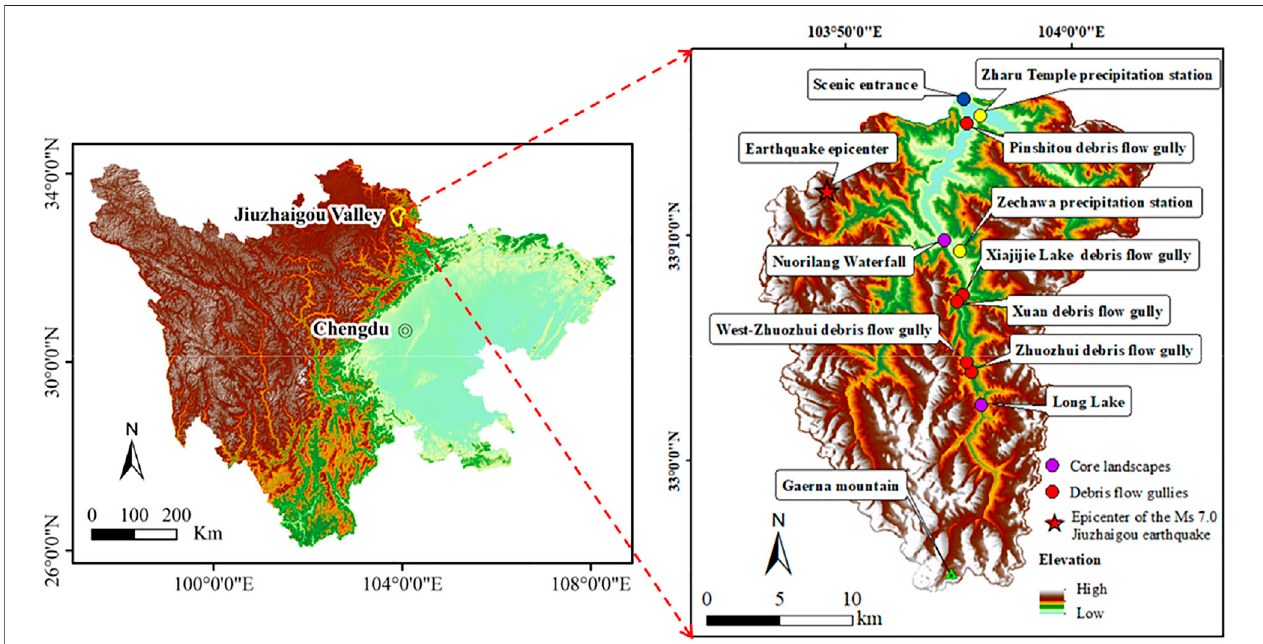
FIGURE 1 | Geomorphological setting of the study area and distribution of debris fl ow gullies in the area.